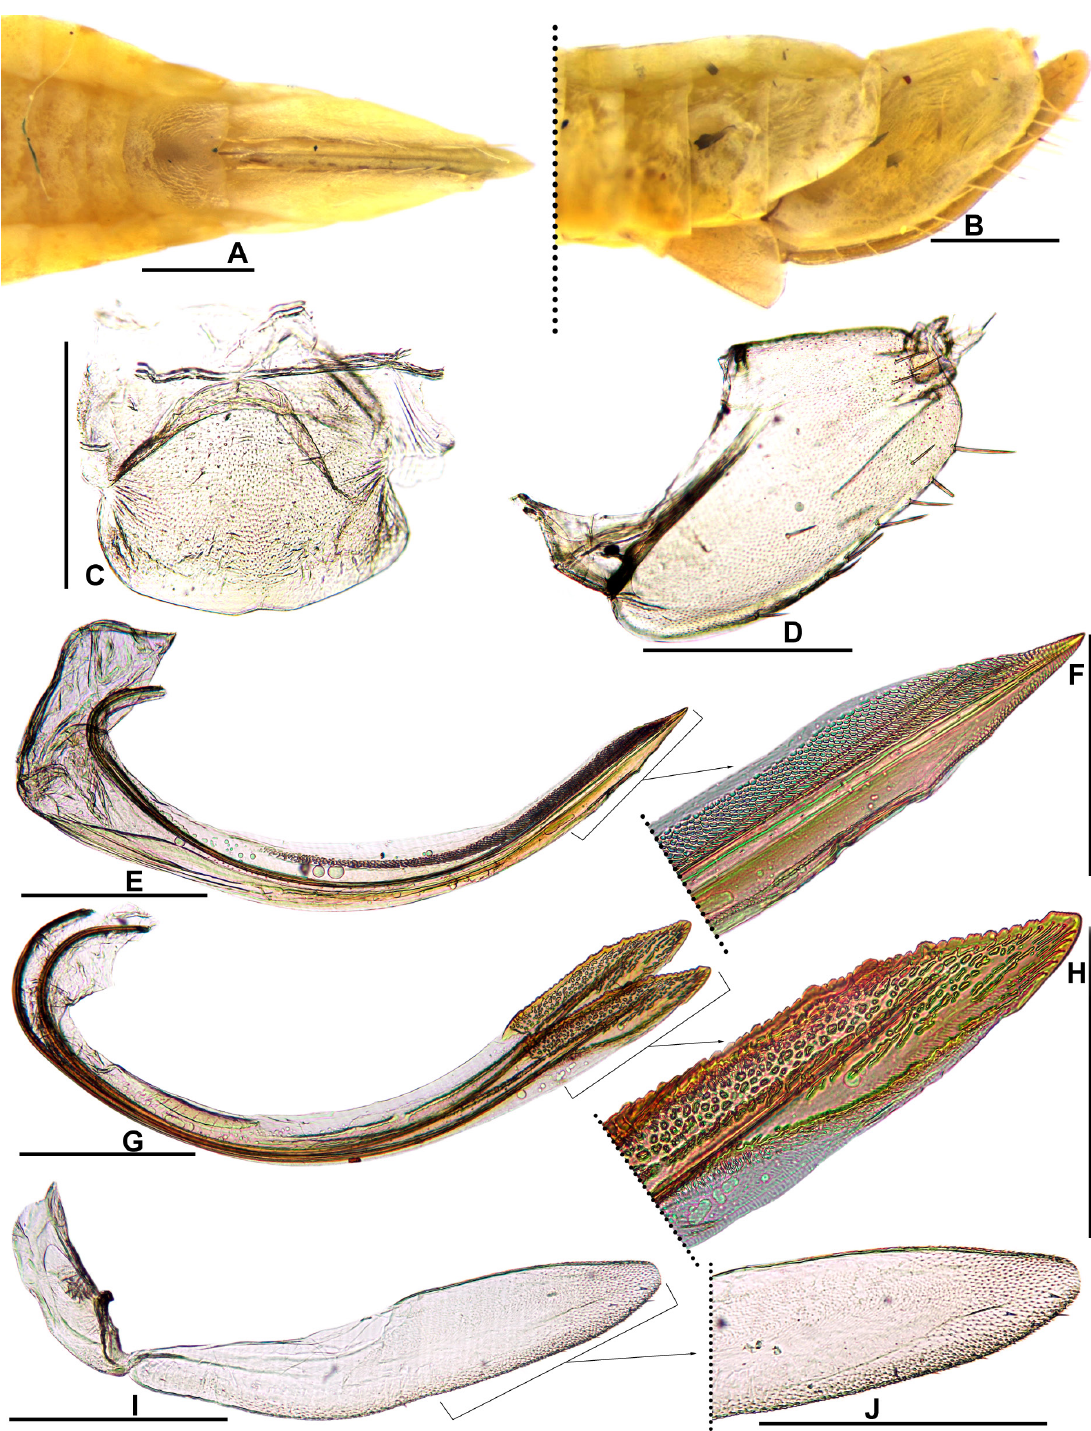
Fig. 4. Takiyaella cavichiolii gen. et sp. nov., ♀, paratype (DZUP 492477). A . Posterior portion of abdomen, ventral view. B . Posterior portion of abdomen, lateral view. C . Sternite VII, ventral view. D . Pygofer and anal tube, lateral view. E . First valvifer and first valvula of ovipositor, lateral view. F . Apex of first valvula, lateral view. G . Second valvula of ovipositor, lateral view. H . Apex of second valvula, lateral view. I . Second valvifer and gonoplac, lateral view. J . Apex of gonoplac, lateral view. Scale bars: A–B = 1.0 mm; C–E, G, I = 0.5 mm; F, H, J = 0.3